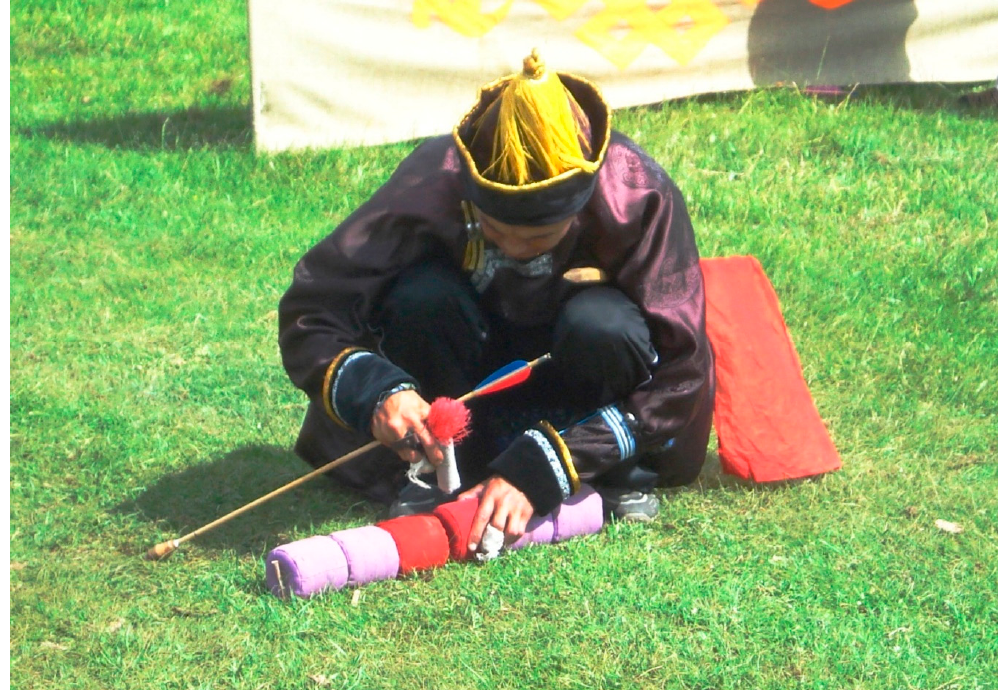
Figure 3. A Buryat archer setting up “sury”, soft targets symbolizing hunted rodents, for his competitors to shoot at during a competition at the Ivolginsk Buddhist monastery in 2010. Photo: Stefan Krist.